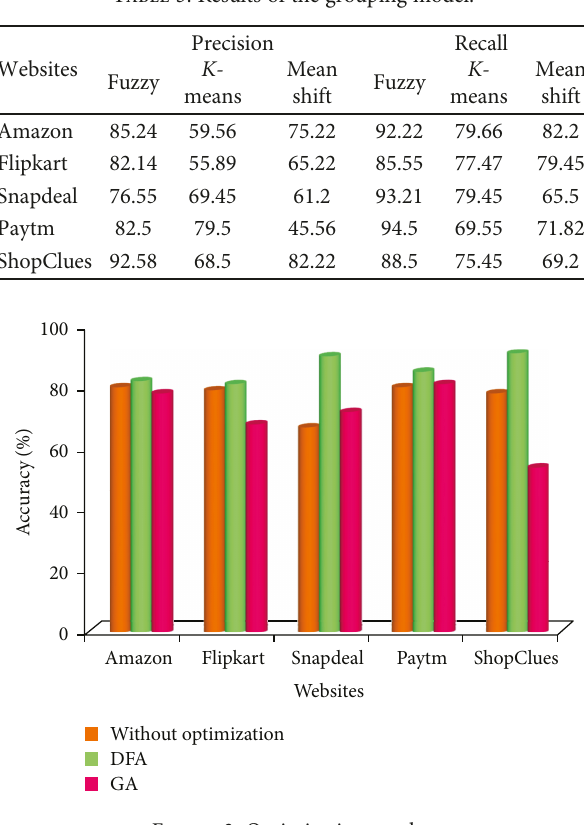
Table 3: Results of the grouping model.